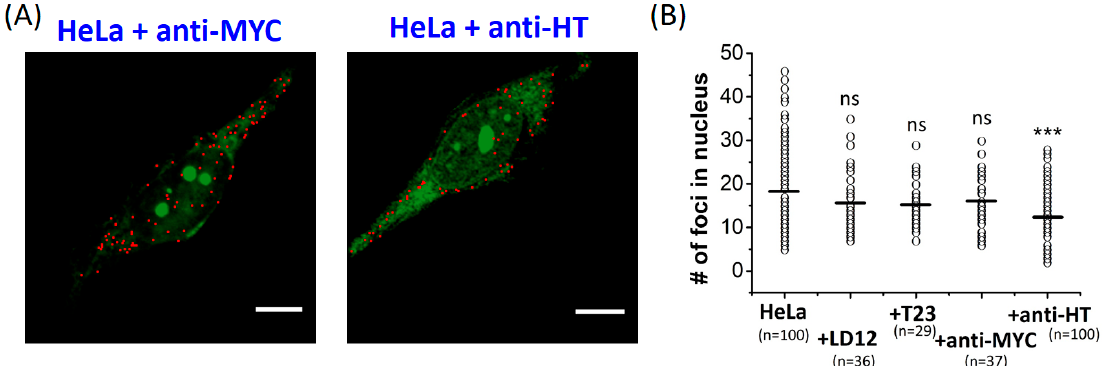
Figure 2. Time-gated fluorescence lifetime imaging microscopy (FLIM) imaging of o -BMVC foci in fixed HeLa cancer cells after the overnight pretreatment of di ff erent oligonucleotides. The binary images of o -BMVC foci in fixed HeLa cells after the pretreatment of anti-MYC and anti-HT ( A ). Scale bar, 10 µ m. The images were presented in pseudo-color and were separated into two components, with color in red (decay time ≥ 2.4 ns) and in green (decay time < 2.4 ns). ( B ) The scatter plots of the number of o -BMVC foci in the nucleus of each fixed HeLa cell, without and with the pretreatment of di ff erent oligonucleotides. The average number of o -BMVC foci was obtained by the total number of o -BMVC foci in the nuclei, divided by the number of cells. ( p -value: *** p < 0.001 and ns: no significance).